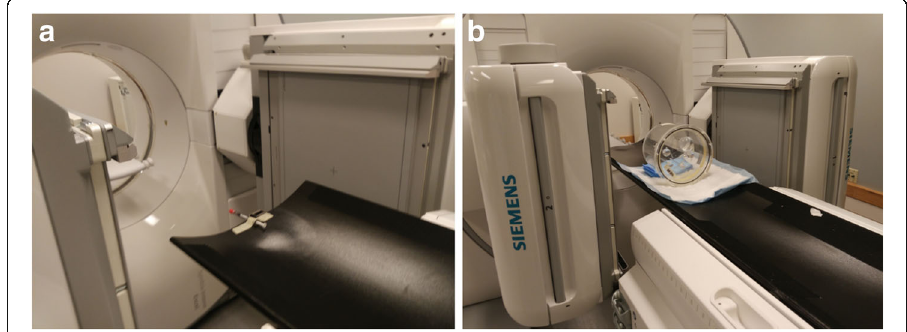
Fig. 1 Examples of experimental configurations used in planar ( a ) and tomographic ( b )